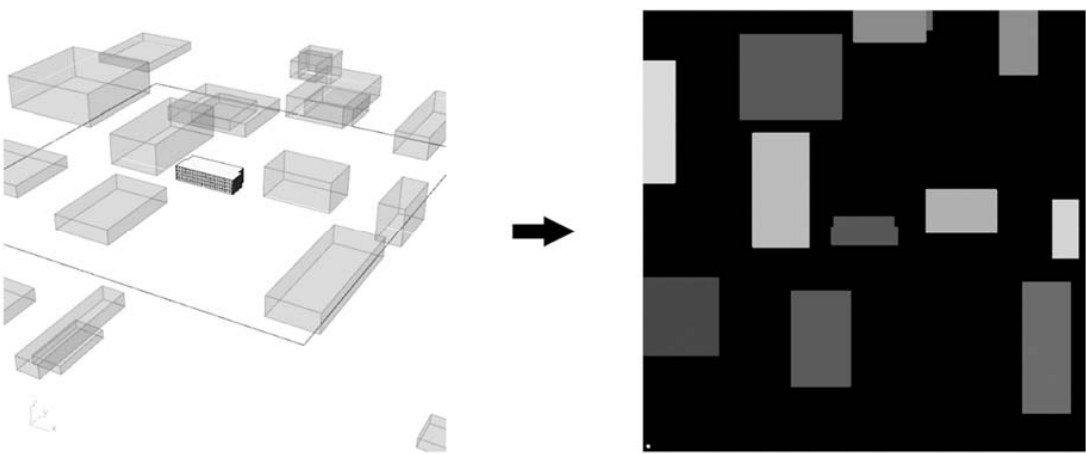
Figure 11. Example of translation of a 3D model into greyscale height map (Z ‐ map).